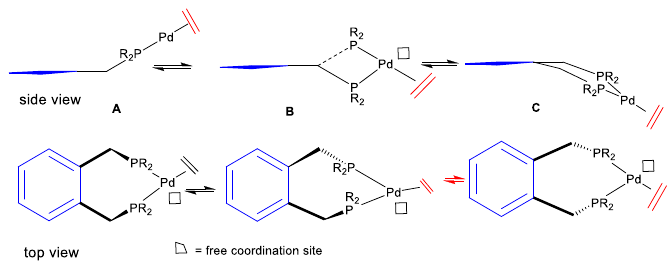
Figure 14. Conformational scheme for the Alpha ligand palladium complex, showing conforma- tional flipping.